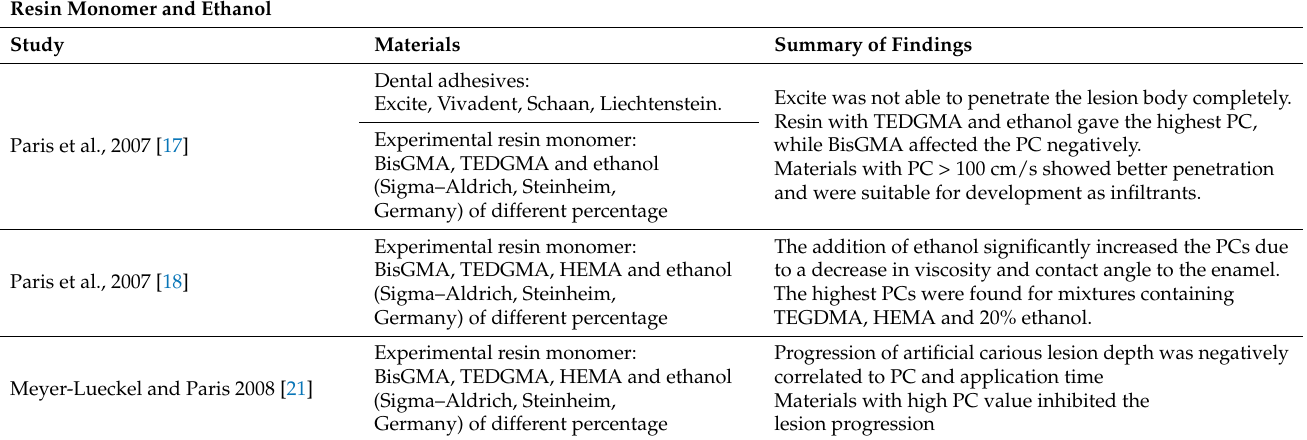
Table 1. Summary of main studies related to the development of